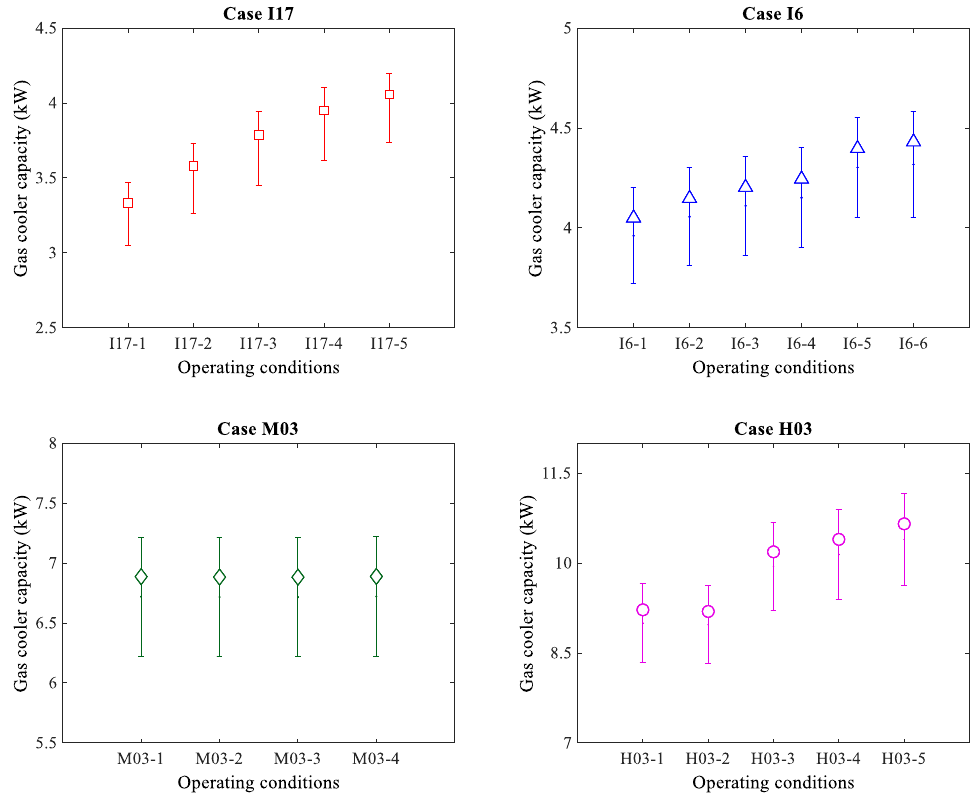
Figure 5. Range of heat transfer rate Q for given operating